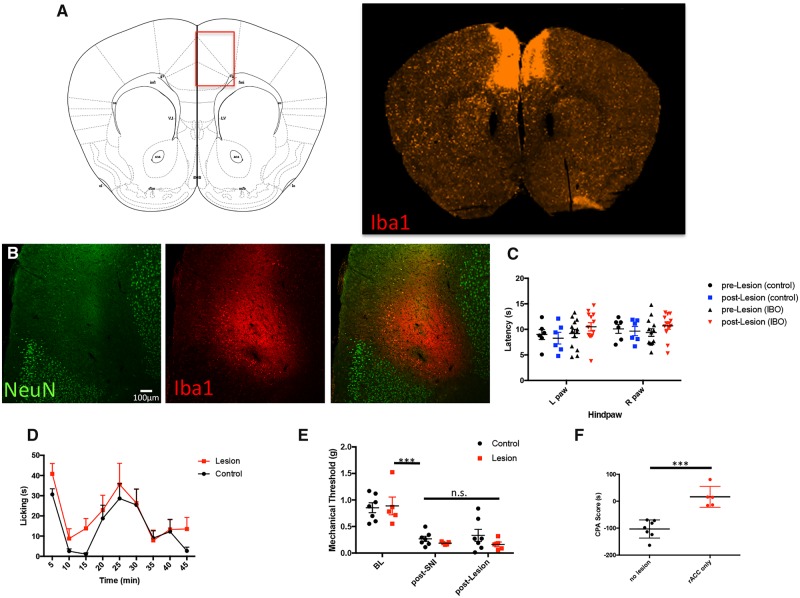

Rostral ACC lesions do not alter the sensory-discriminative features of the pain experience. (A) Schematic illustrating the location of the rACC (left) and Iba1-immunostained section (right) illustrating microglial activation induced by the ACC lesion. (B) Representative example of excitotoxic lesions of the rACC. Immunostaining with antibodies to NeuN (green) and Iba1 (red) define regions of neuronal loss and activation of microglia in the ACC. (C) Left and right hindpaw withdrawal latencies to radiant heat in mice with (n = 13) and without (n = 6) rACC ibotenic acid (IBO)-induced lesions. There are no significant differences in acute thermal thresholds between the two groups (RM 2-way ANOVA, Sidak’s multiple comparison test, not significant). (D) Duration of hindpaw licking after formalin injection in mice with (red, n = 12) and without/control (black, n = 9) rACC lesions. There is no significant difference between the groups (RM 2-way ANOVA, Sidak’s multiple comparison test). Data are presented as the mean ± SEM licking duration within sequential 5-min bins. (E) Mechanical threshold ipsilateral to the partial sciatic nerve injury (SNI) before injury (baseline, BL), after injury (post-SNI) and 1 week after rACC lesion (post-Lesion). Mechanical allodynia ipsilateral to the injury did not differ in mice with (n = 9, red) or without (n = 7, black) ACC lesions (RM 2-way ANOVA followed by Tukey’s multiple comparison test, ***P < 0.001). Data are represented as mean ± SEM (F) Compared to control mice (n = 7, black), rACC lesioned mice (n = 5, red) do not show formalin-induced aversion in the CPA test (Student’s t-test, ***P < 0.001).